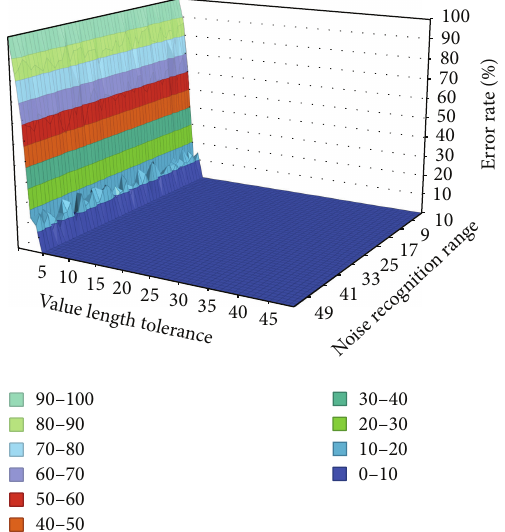
Figure 11: FAR and FRR performance of Key